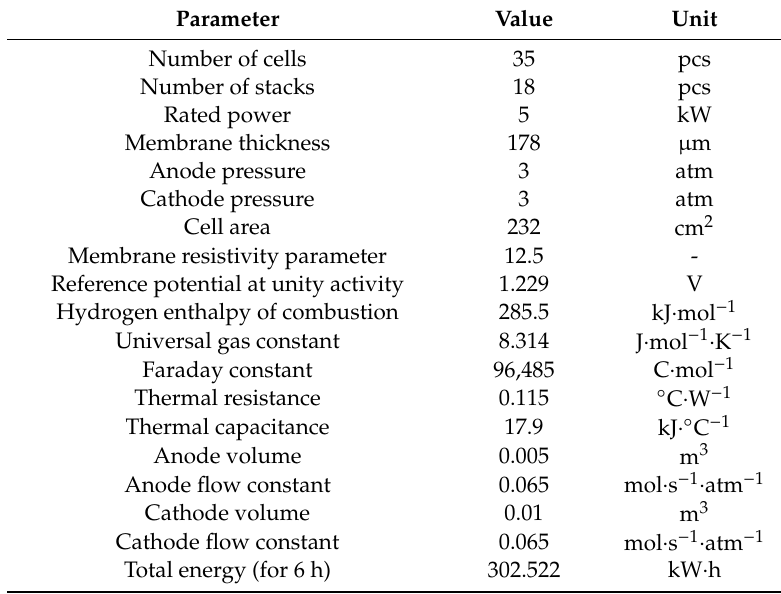
Table 4. Fuel cell system